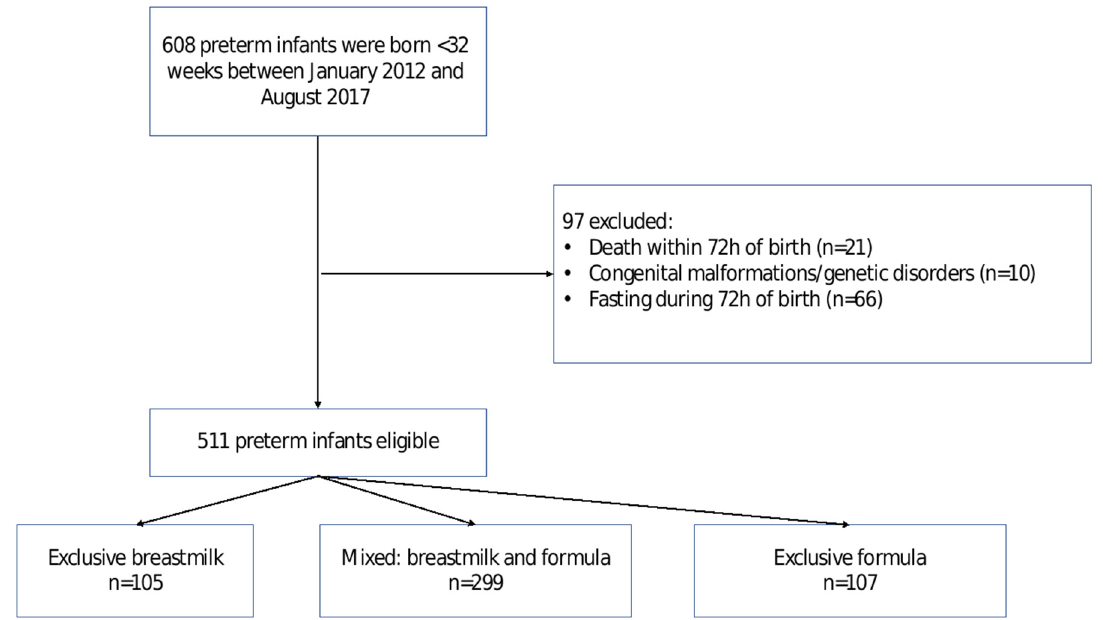
Figure 1. Flow chart of infants in the study.